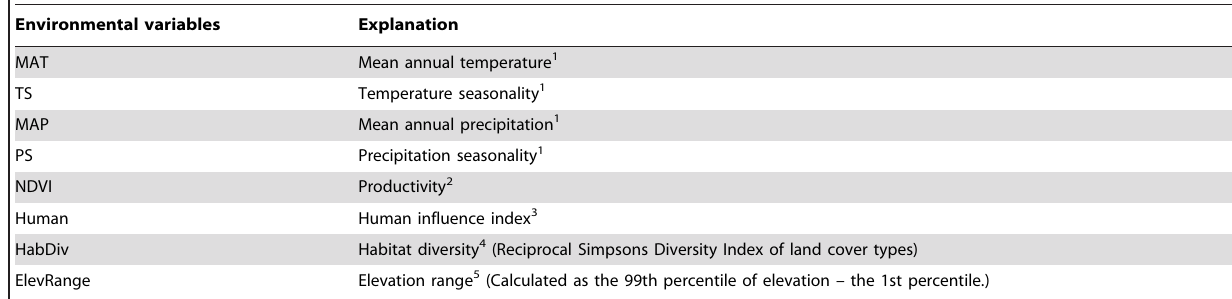
Table 1. Environmental